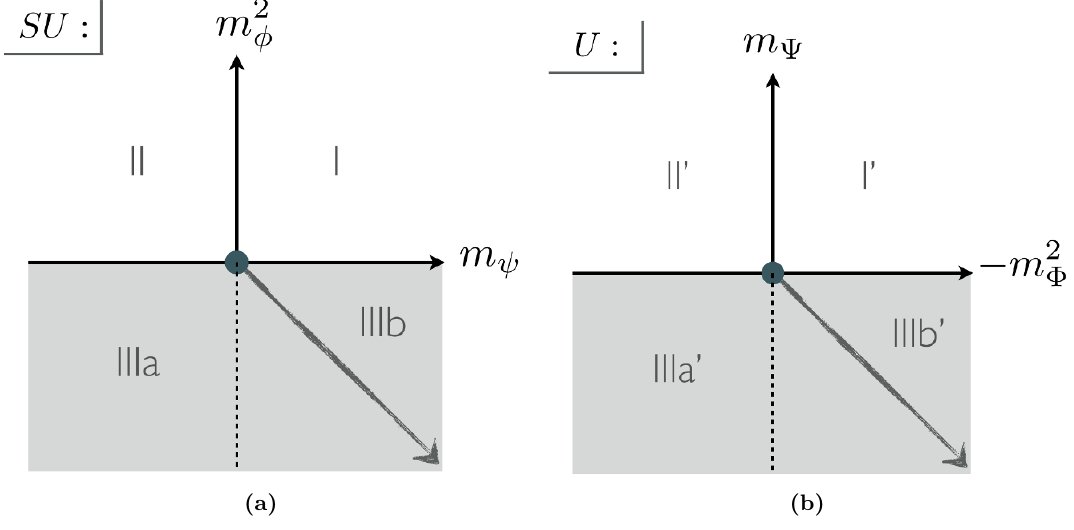
Chern- (cid:0) k + Nf 2 Chern-Simons theory N (cid:0) N s 2